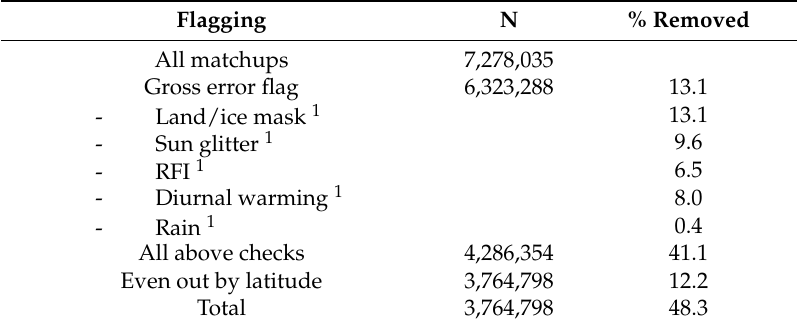
Table 1. Summary of 2010 data discarded due to the different filters applied. Flagging N % Removed All